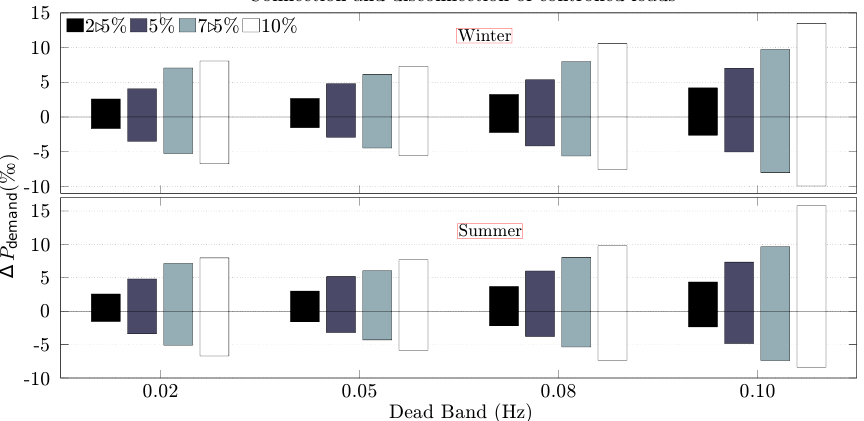
Figure 12. Increase of the time during which bands and controllable loads ; see Equation (6).